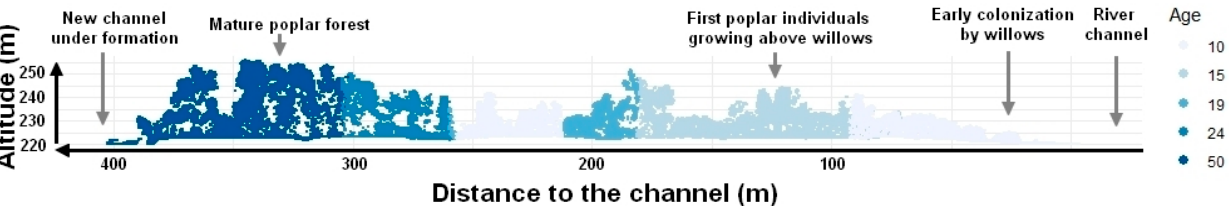
Figure 9. LiDAR cross-section showing the developmental stages of the pioneer poplar forest of the Ain River on the Chatillon site. Ain River on the Chatillon